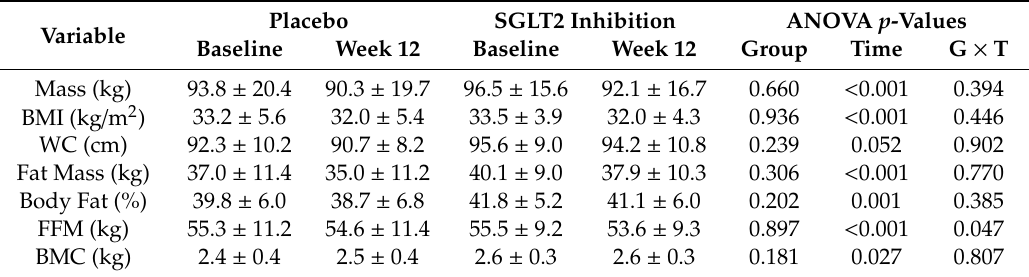
Table 3. Body mass and composition prior to and following 12 weeks of dietary counselling for weight loss supplemented with placebo or SGLT2